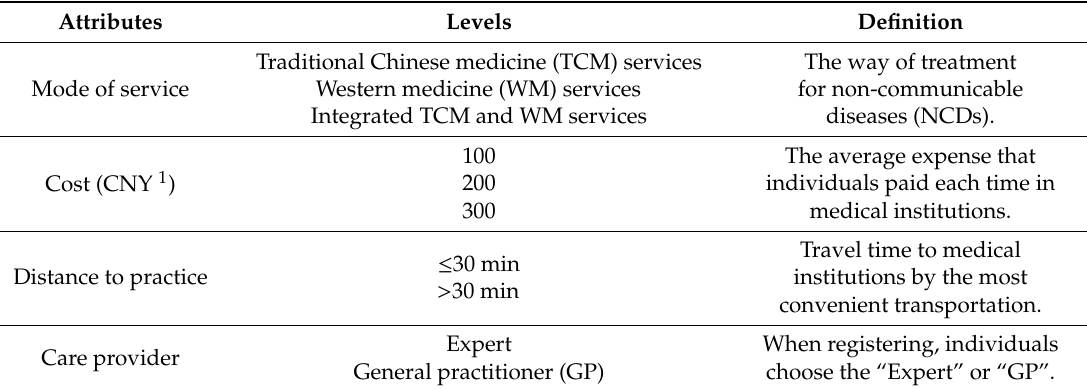
Table 1. Discrete choice experiment attributes and attribute